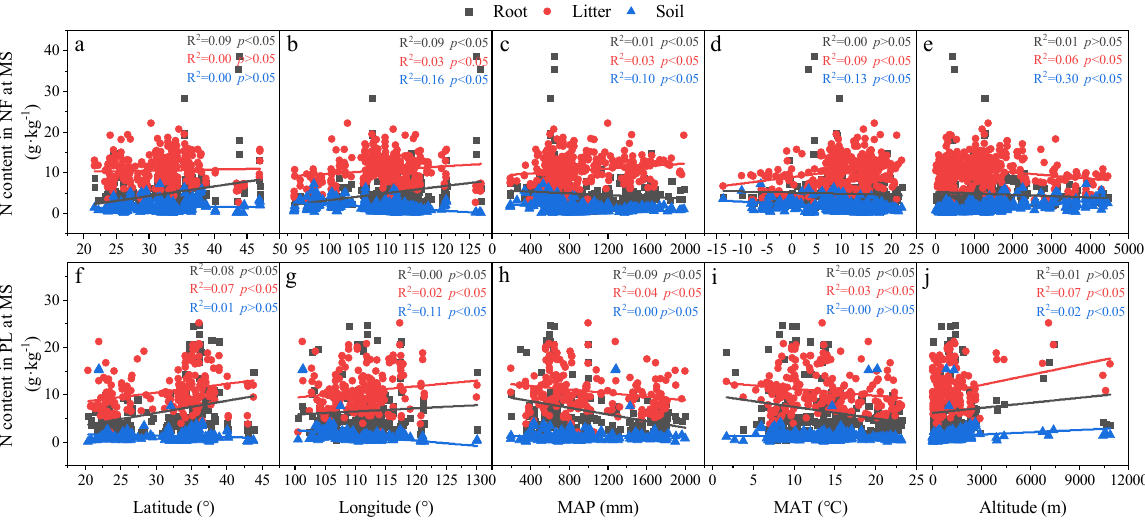
Figure A4. N content changes with latitude ( a , f ), longitude ( b , g ), mean annual precipitation (MAP) ( c , h ), mean annual temperature (MAT) ( d , i ) and altitude ( e , j ) in different forest origins in the early stage (ES). The number of forest sites are 149 and 102 for NF − ES and PL − ES, respectively.